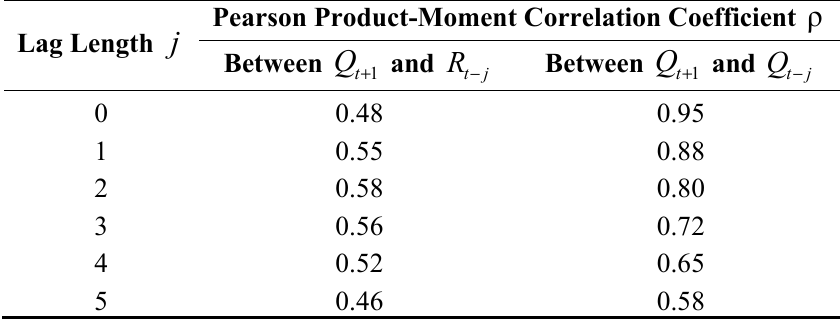
Table 1. Values of Pearson product-moment correlation